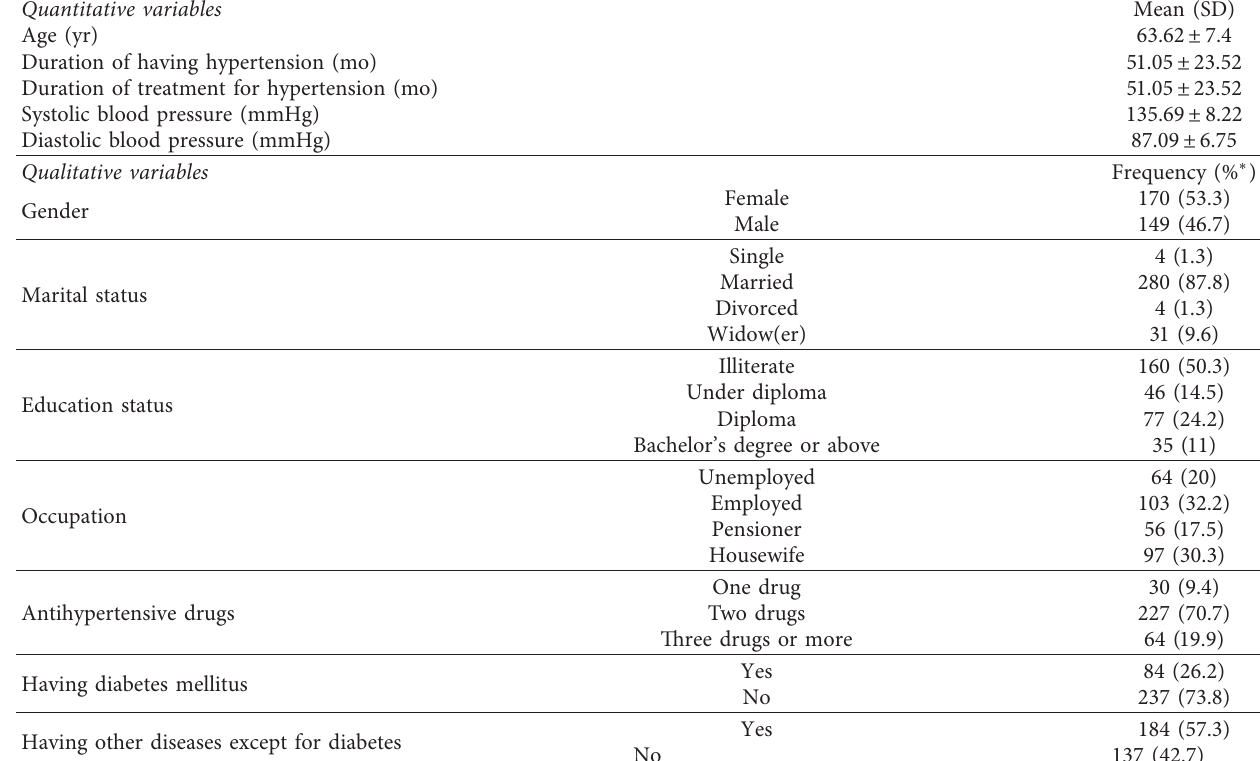
Table 3: Description of the study sample ( n �